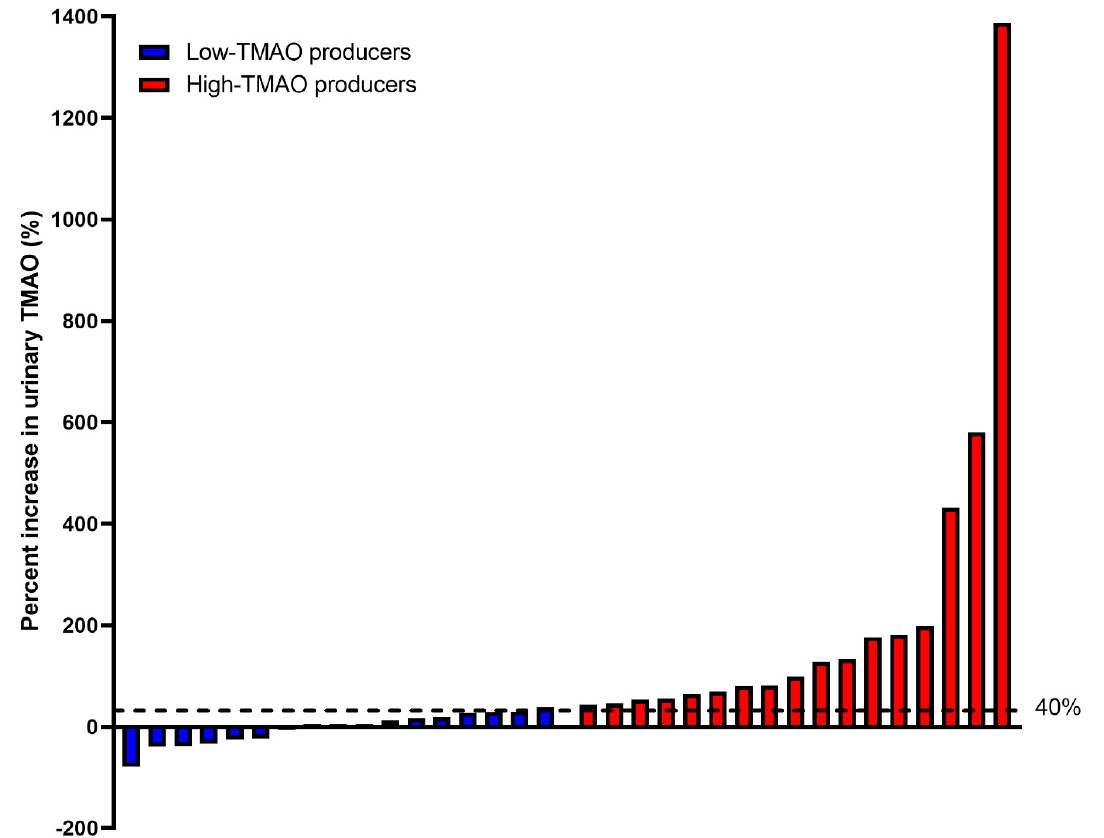
Figure 4. Percentage change in urinary trimethylamine- N -oxide (TMAO) concentrations following choline bitartrate consumption shown in rank-order of response. The percentage change ranged from − 80% to 1400% among participants. The median value of 40% was used as a cutoff to stratify the participants into high-TMAO producers ( n = 17; those with ≥ 40% urinary TMAO increase from 0 min study-baseline in response to choline bitartrate) and low-TMAO producers ( n = 17; those with < 40% urinary TMAO increase from 0 min study-baseline in response to choline bitartrate) were compared for the gut microbiome analyses.